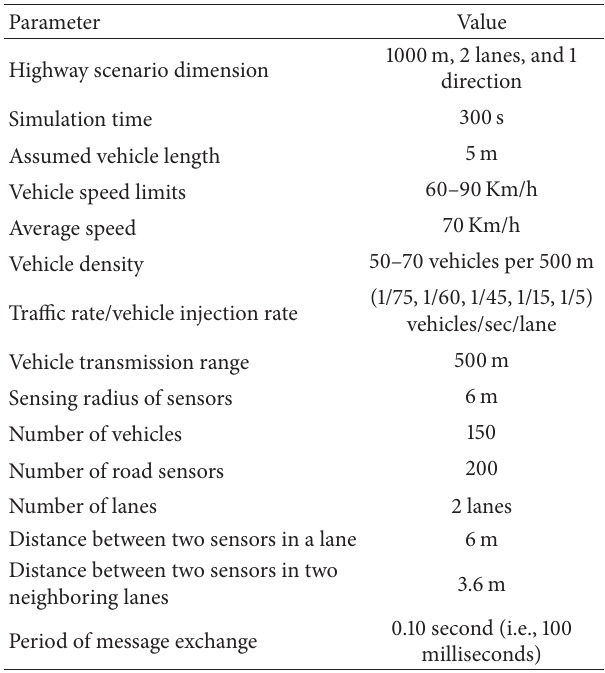
Table 1: Simulation